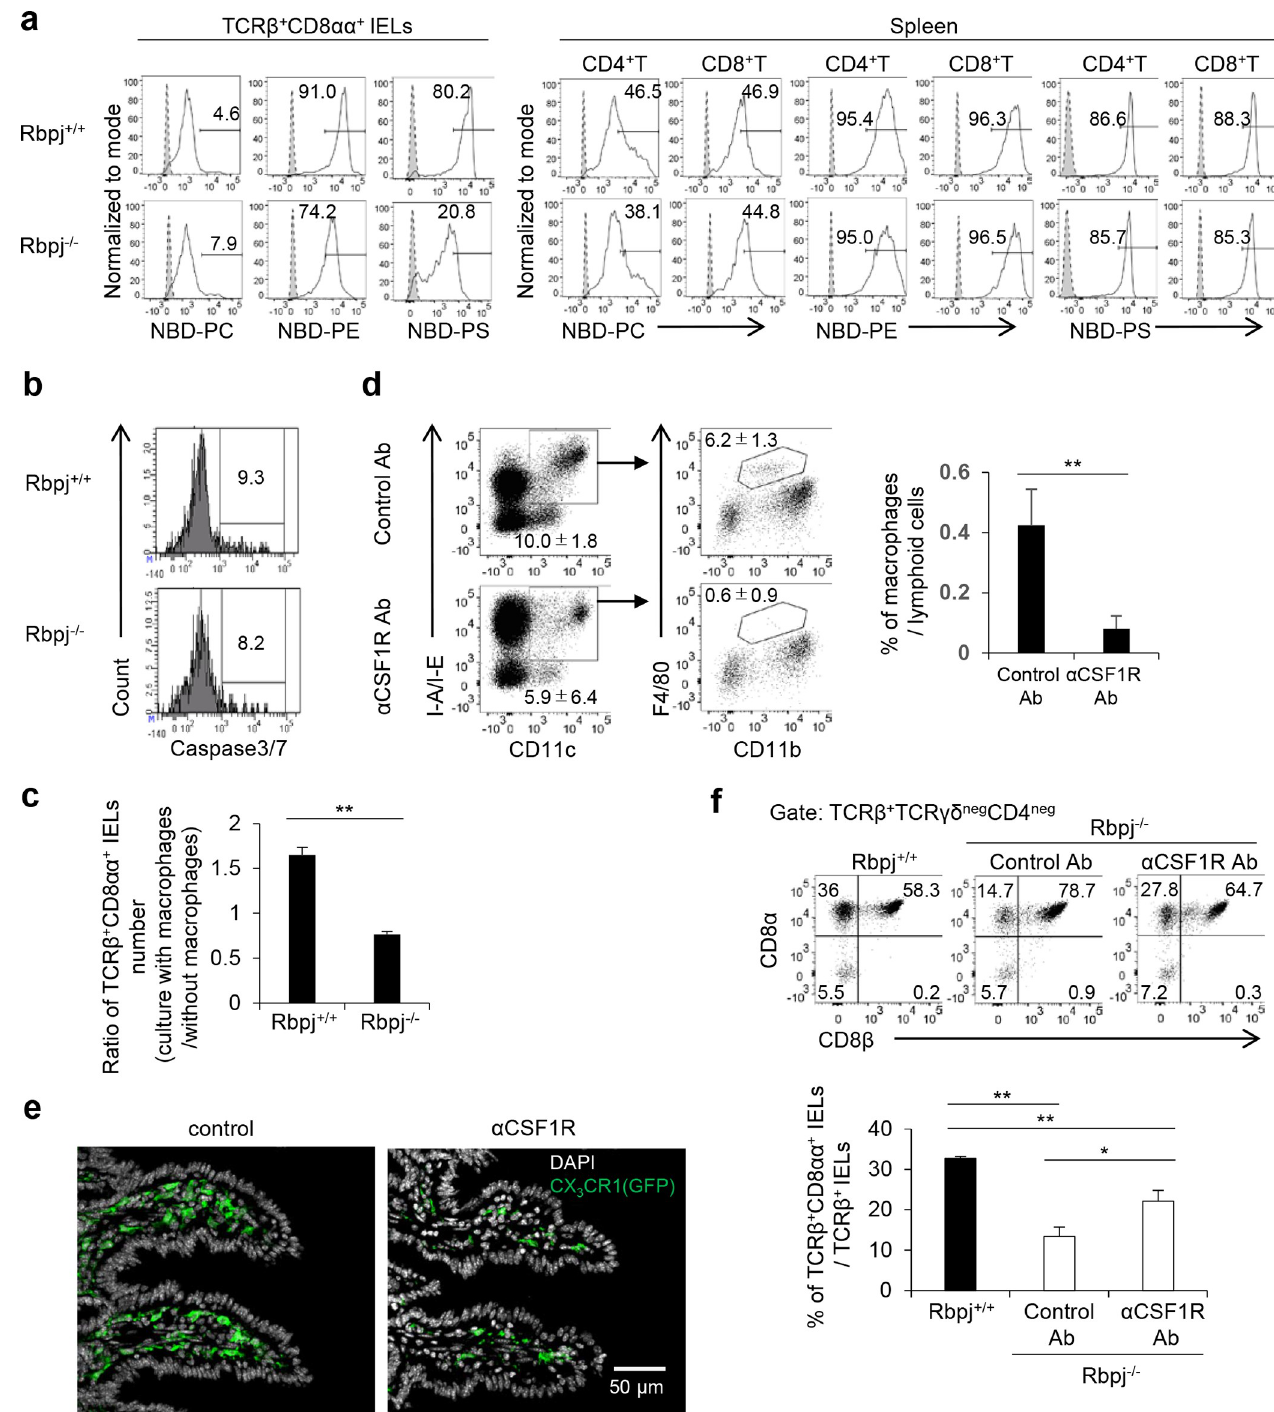
Fig 6. Rbpj -deficient TCR αβ + CD8 αα + IELs have low flippase activity. (A) TCR αβ + CD8 αα + IELs or splenic CD4 + or CD8 α + T cells from Rbpj +/+ or Rbpj − / − mice were incubated with fluorescence-conjugated phospholipid (NBD-PS, NBD-PE, or NBD-PC), and the fluorescence was evaluated 10 min later. Shadow: unincubated control; solid line: NBD-PS, NBD-PE, or NBD-PC. (B) Expression of cleaved caspase3/7 in TCR αβ + CD8 αα + IELs from Rbpj +/+ or Rbpj − / − mice. (C) Sorted TCR αβ + CD8 αα + IELs (CD45.2) from Rbpj +/+ or Rbpj − / − mice were incubated with peritoneal macrophages (CD45.1/45.2) for 2 h. The number of CD45.2-positive TCR αβ + CD8 αα + IELs was counted in the presence or absence of macrophages by flow cytometry. Data are shown as the ratio of the number of TCR αβ + CD8 αα + IELs with macrophages to the number of TCR αβ + CD8 αα + IELs without macrophages. The data are representative of three independent experiments and are shown as mean ± S.D., and �� indicates p < 0.01. (D) Flow cytometry of CD11c + MHCclassII + CD11b + F4/80 + macrophages from the small